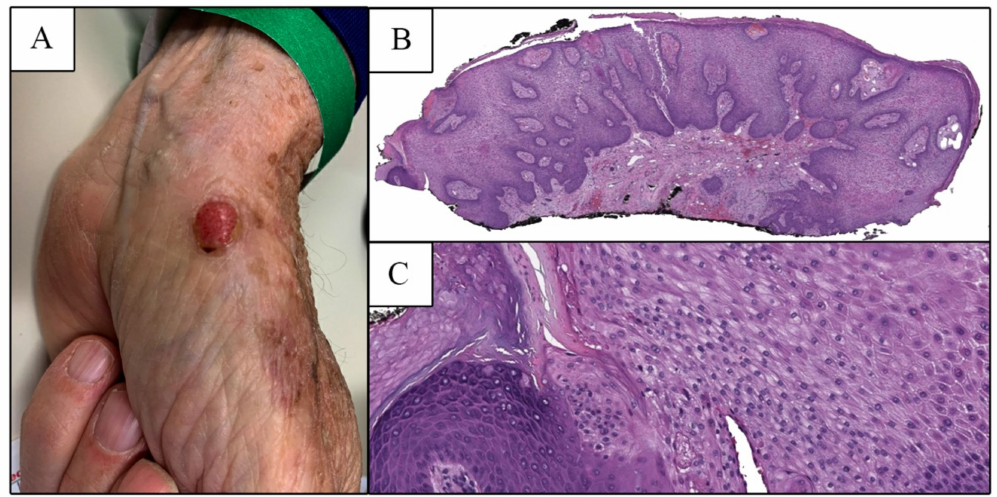
Figure 1. ( A ) Clinical image of the initial left thenar eminence lesion, prior to shave biopsy. ( B ) Low power examination of the initial shave biopsy specimen revealed an epidermal tumor exhibiting psoriasiform hyperplasia composed of pale staining cells (H&E, 20 × ) with ( C ) an abrupt transition to the adjacent normal epidermis at one lateral edge (H&E, 100 × ).